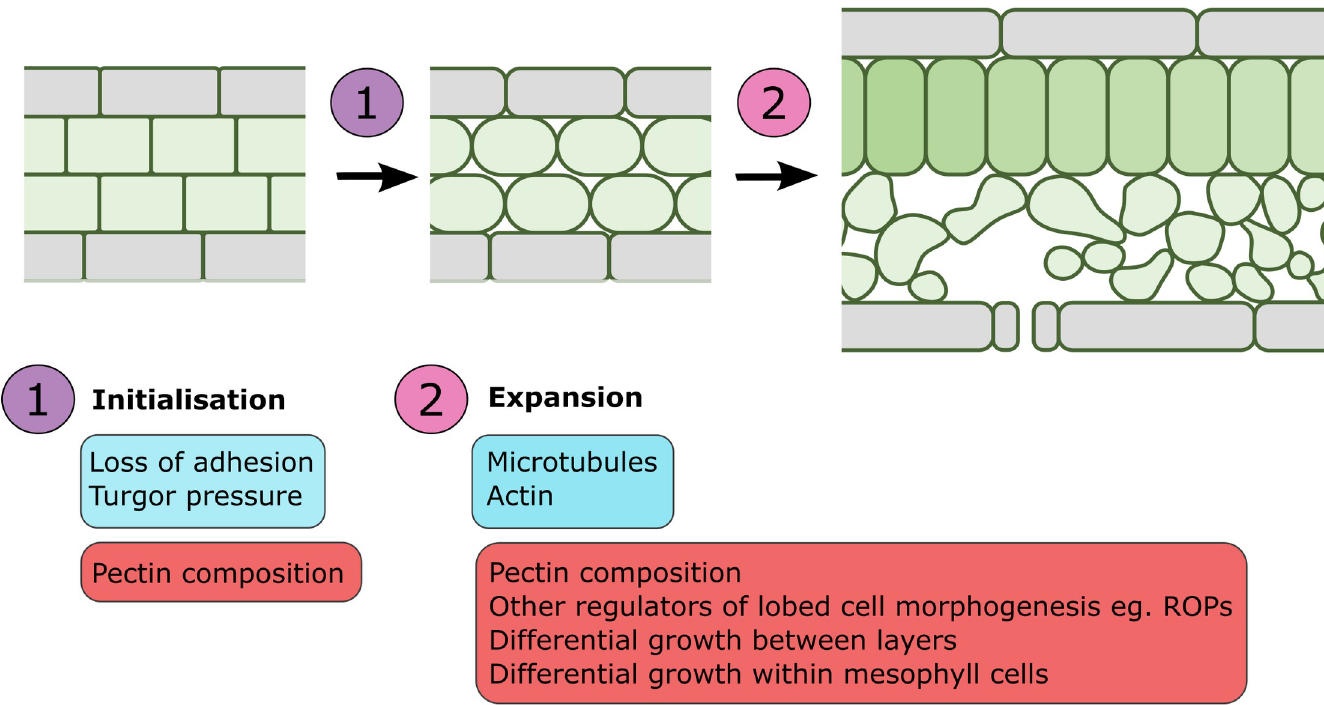
Fig 4. Cellular processes in air space formation. Air space formation can be divided into 2 stages: (1) initialisation; and (2) expansion. In initialisation, a combination of turgor pressure and loss of adhesion causes small air spaces to form at multicellular junctions. In expansion, the actin and microtubule cytoskeletons regulate cellular morphogenesis to promote air space formation. Processes known to control air space formation are highlighted in blue, and processes that have been hypothesised to control air space formation, but remain untested, are highlighted in red.